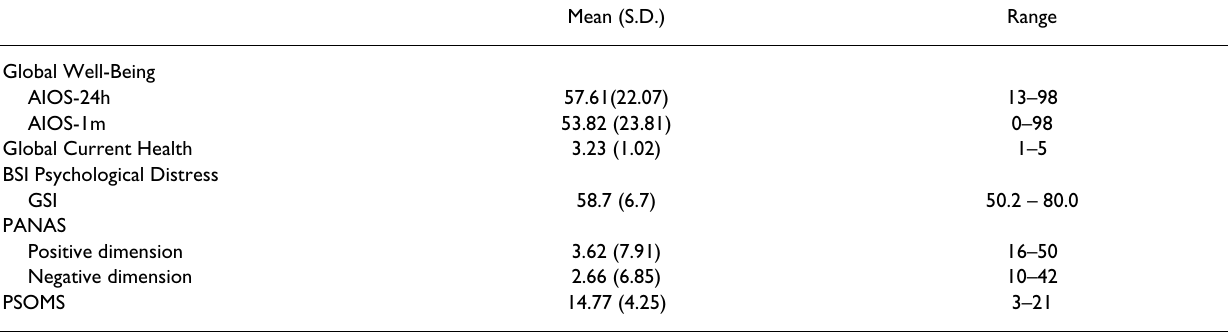
Table 5: Mean (S.D.) and Range for All Scales (N = 62).